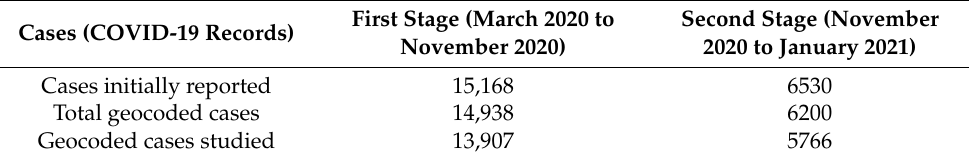
Table 1. Number of records in the study detailed by research stages. Cases (COVID-19